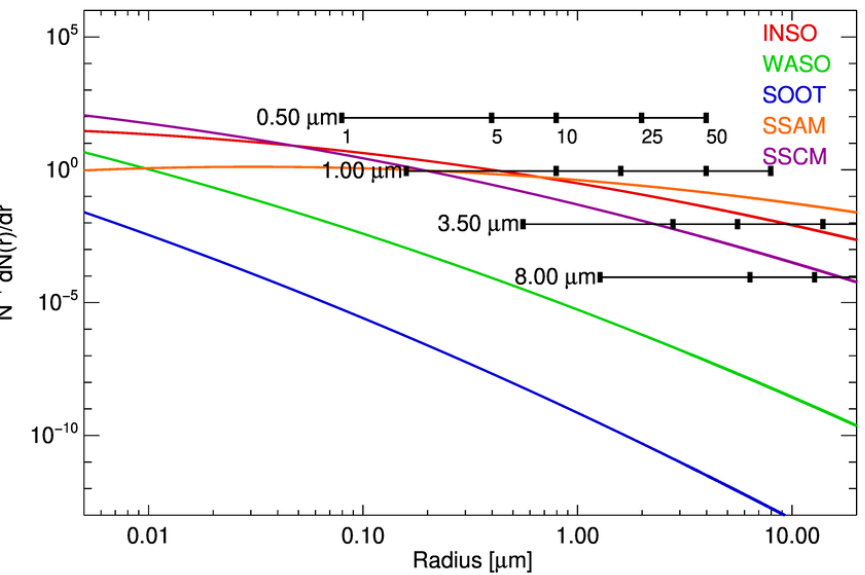
Figure 3. Lognormal size distribution of compositional aerosols, INSO (red), WASO (green), SOOT (blue), SSAM (orange), and SSCM (purple). The size parameters ( χ = 2 π r / λ ) for various wavelengths (0.5, 1.0, 3.5, and 8.0 µ m) are indicated as the black horizontal